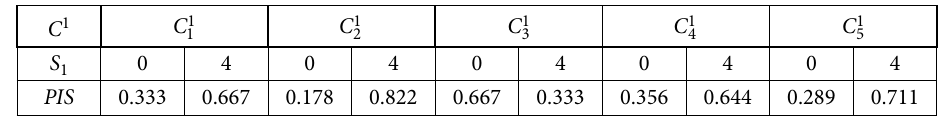
Table 4. The PIS of different attributes, scales and stages Data from the first survey (2014)